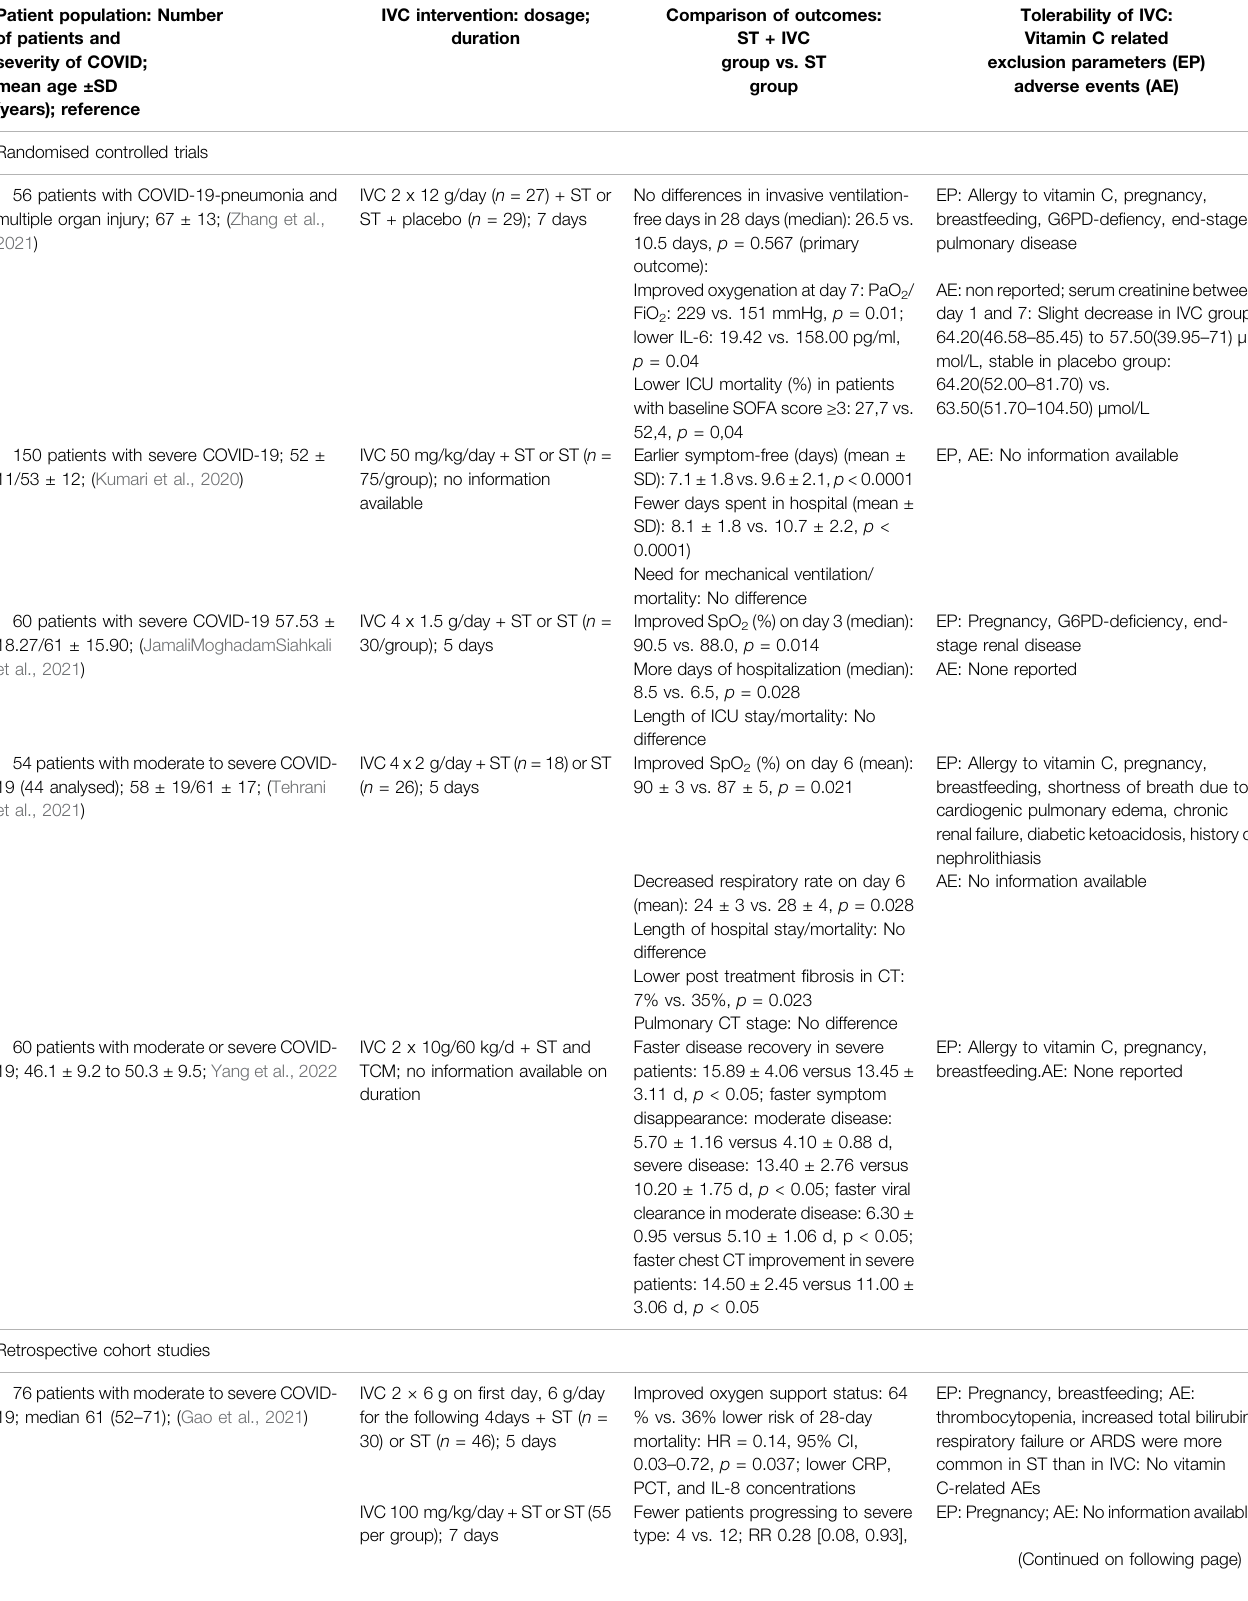
TABLE 2 | Clinical studies on patients with moderate to severe stages of COVID-19 with add-on IVC to standard therapy (ST). Patient population: Number of patients and severity of COVID; mean age